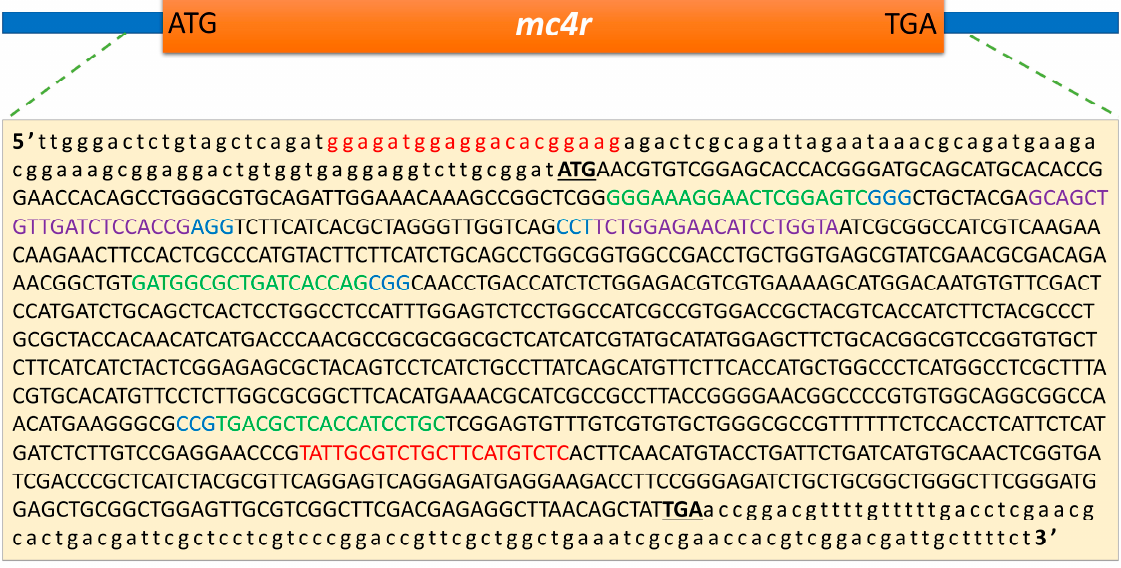
Figure 1. The genomic target sites of the sgRNAs in the channel catfish, Ictalurus punctatus , melanocortin-4 receptor ( mc4r ) gene. The coding and non-coding sequences are indicated by uppercase and lowercase letters, respectively. The start and stop codons are represented by bold uppercase letters. The primer sites are indicated in red. The gRNA target sites for electroporation are indicated in purple with a protospacer-adjacent motif (PAM) in blue. The gRNA target sites for microinjection are indicated in green, with PAM in blue. ATG and TGA represent the start and stop codons,